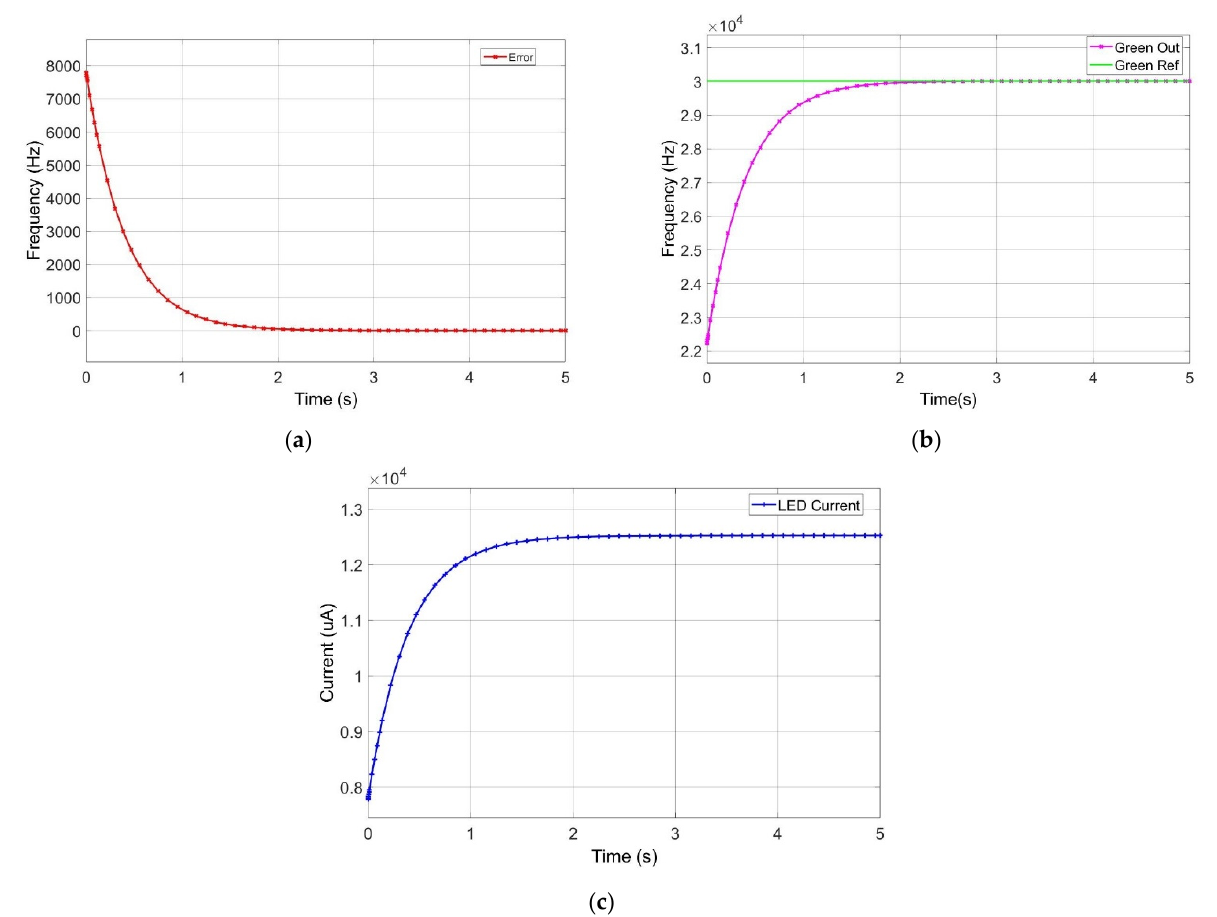
Figure 7. Simulation waveforms of proposed control algorithm for LED module calibration: ( a ) green frequency reference and output value; ( b ) output current value; ( c ) error between reference and output green frequency.